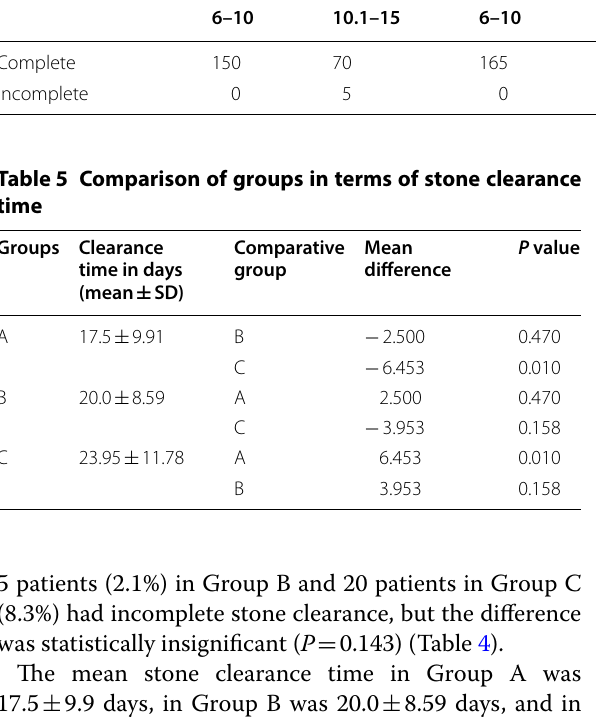
Table 4 Comparison of groups in terms of stone clearance according to stone size Stone clearance